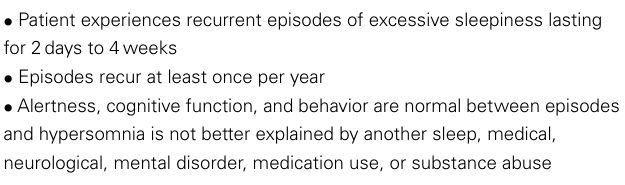
Table 1 | Diagnostic criteria for recurrent hypersomnia and Kleine–Levin syndrome